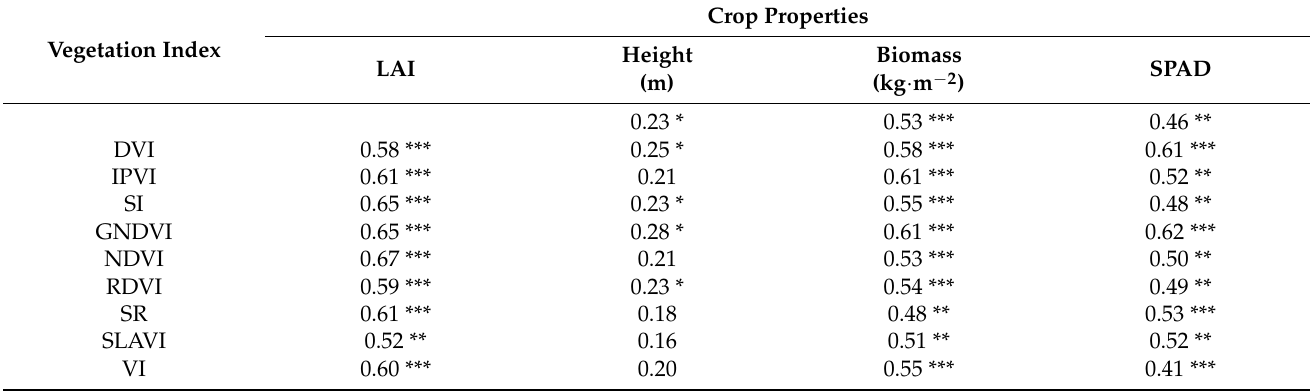
Table 6. Coefficient of determination for the association between various vegetation-SRIs obtained from in situ spectroradiometry and Egyptian wheat characteristics in three years, collected from the study